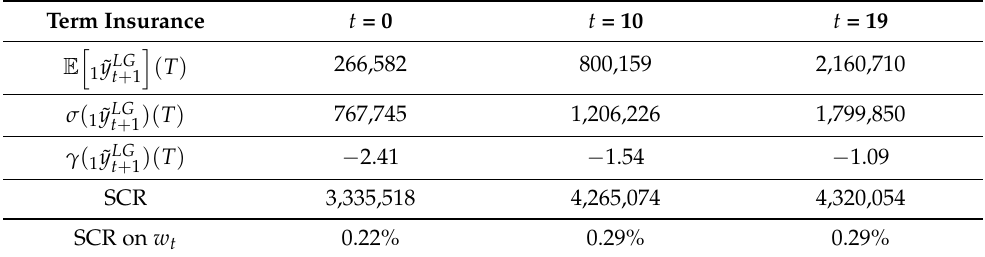
Table 9. Local GAAP results—Term